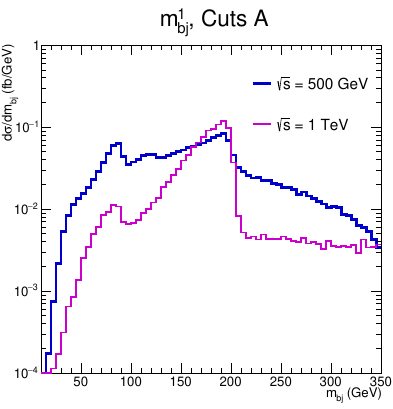
after Cuts A for 500 GeV (blue) and 1 TeV (magenta) C.M. Figure 5 . Reconstructed m 1 bj